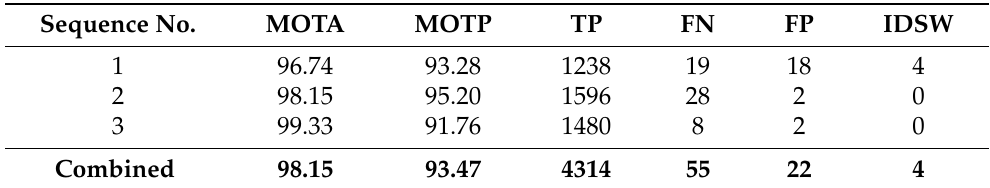
Table 3. Scenario 1—category 2 Quantitative results of the tracker’s performance to track objects of category 2 (tugboat) in scenario 1. Scenario 1 consists of three sequences involving both moving and static objects, and no occlusion or dynamic movement of the camera is applied.